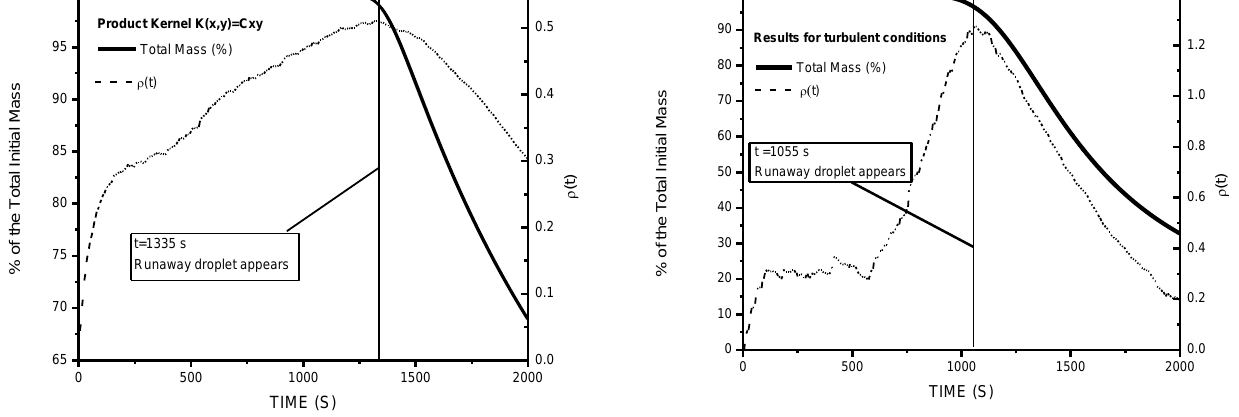
Fig. 1. Time evolution of the parameter ρ defined in Eq. 5 (dashed line and right axis) and the total mass (solid line and left axis) calculated from the numerical solution of the KCE. The results were obtained for the product kernel K(x,y)=Cxy, ( C =5.49×10 10 cm 3 g -2 s -1 ).